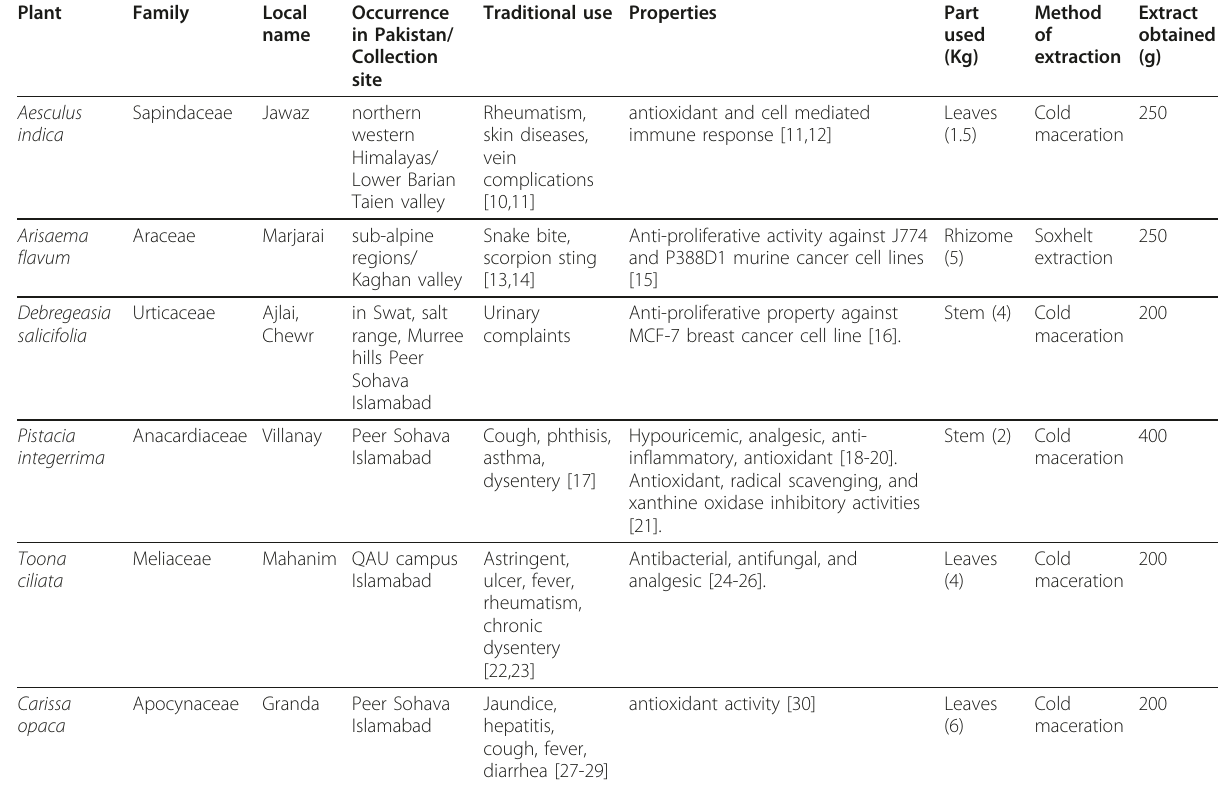
Table 1 Summary of plants, parts used and extraction